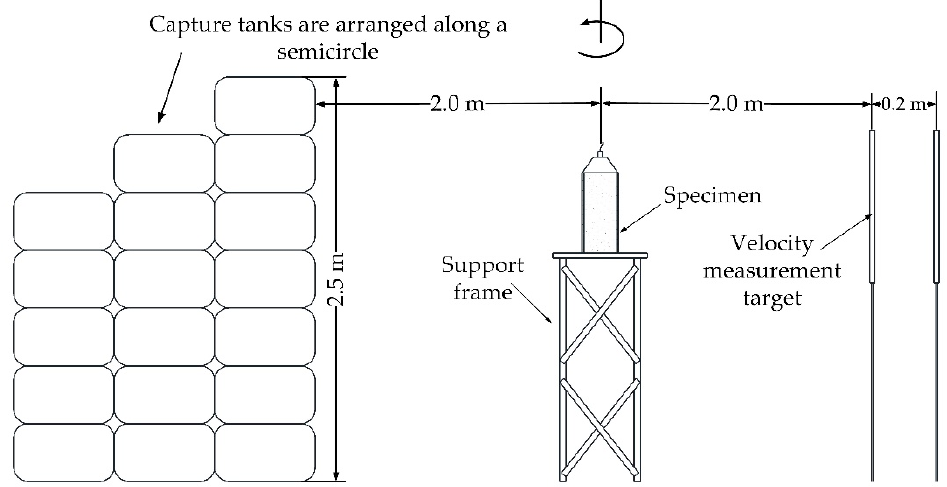
Figure 17. Elevation view of the experimental setup.